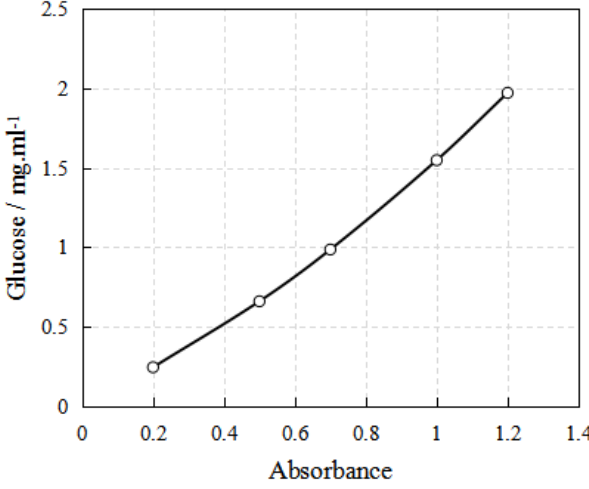
Figure 1. The standard curve of glucose.